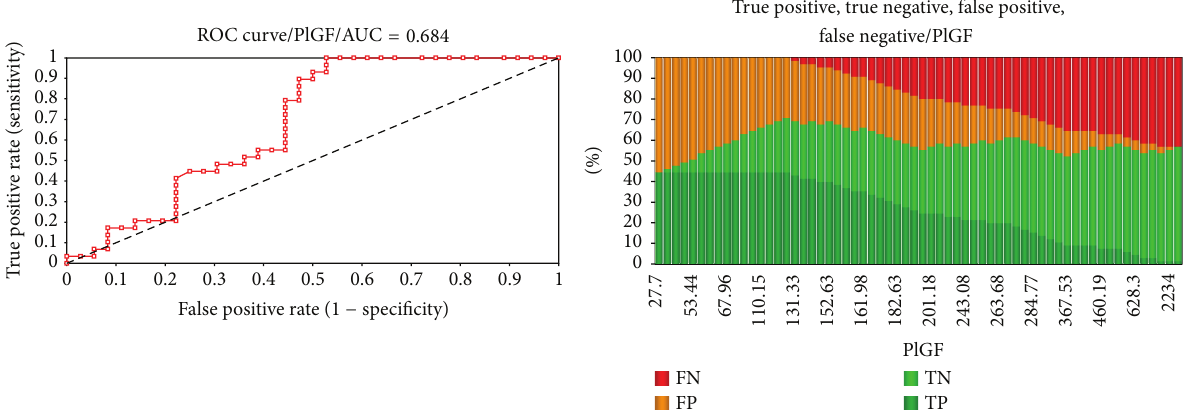
Figure 1: ROC curve and AUC and predictive characteristics of PlGF.